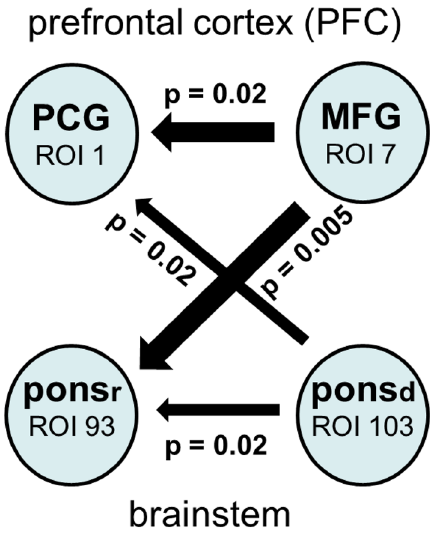
Figure 6. Significant increases in information flow in HA relative to LA. Differences in coupling strength are indicated by the widths of the arrows. Significant changes of the flows are indicated by p